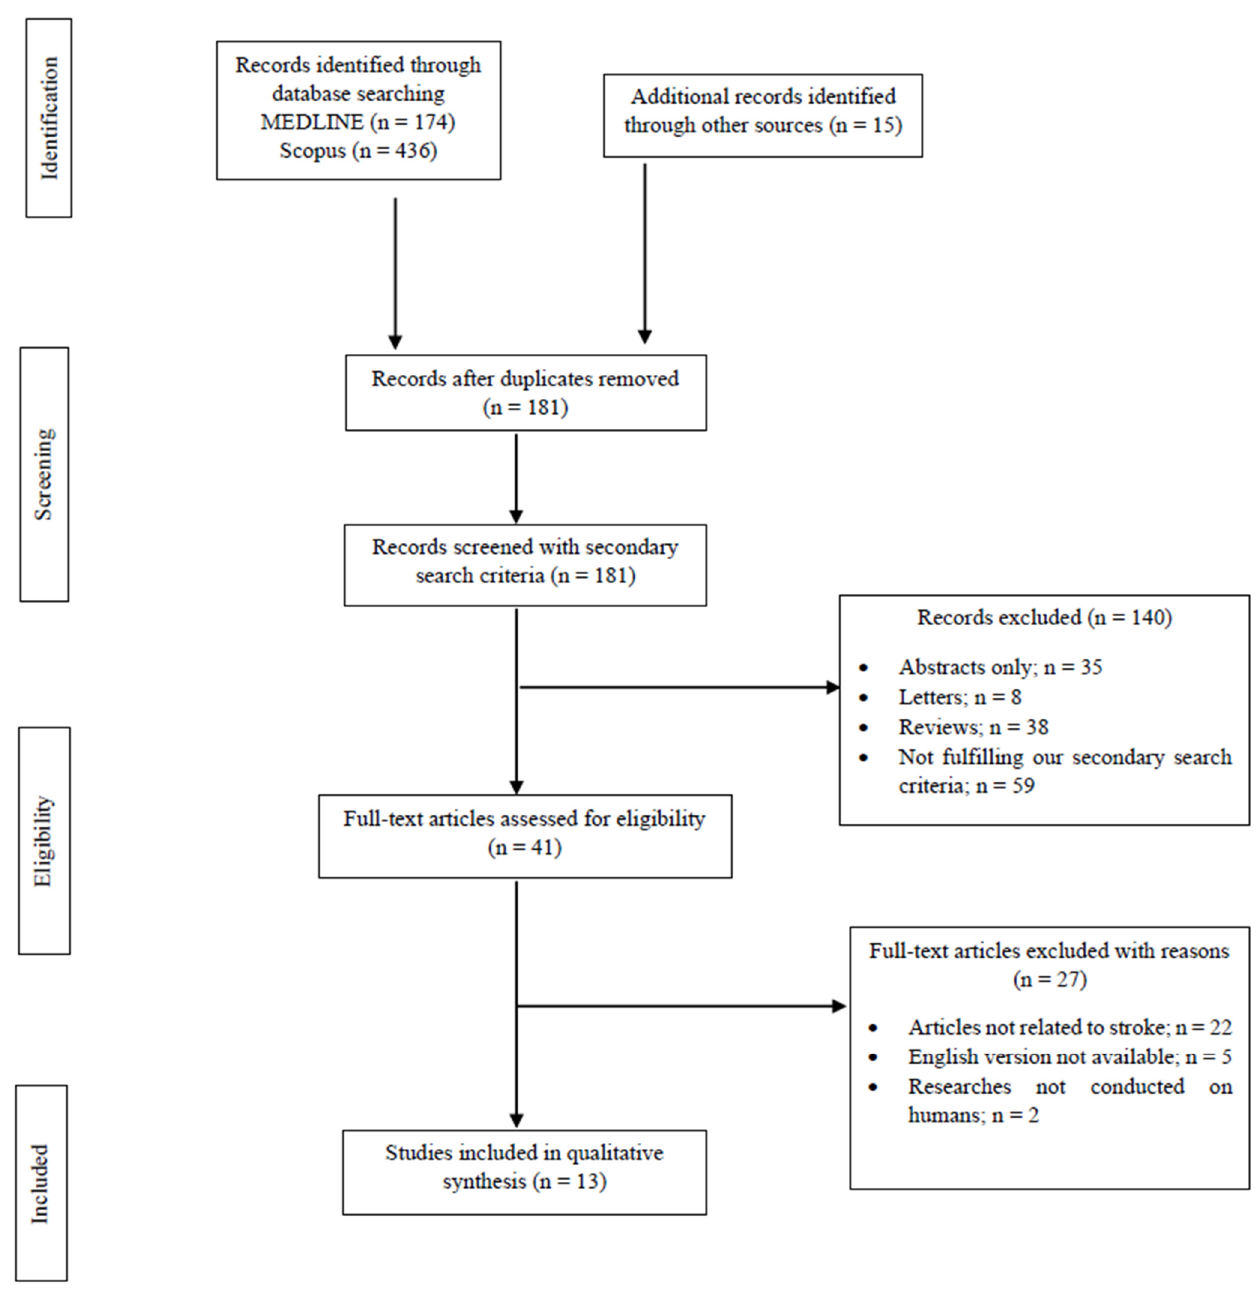
Figure 1. Study flowchart (PRISMA diagram).